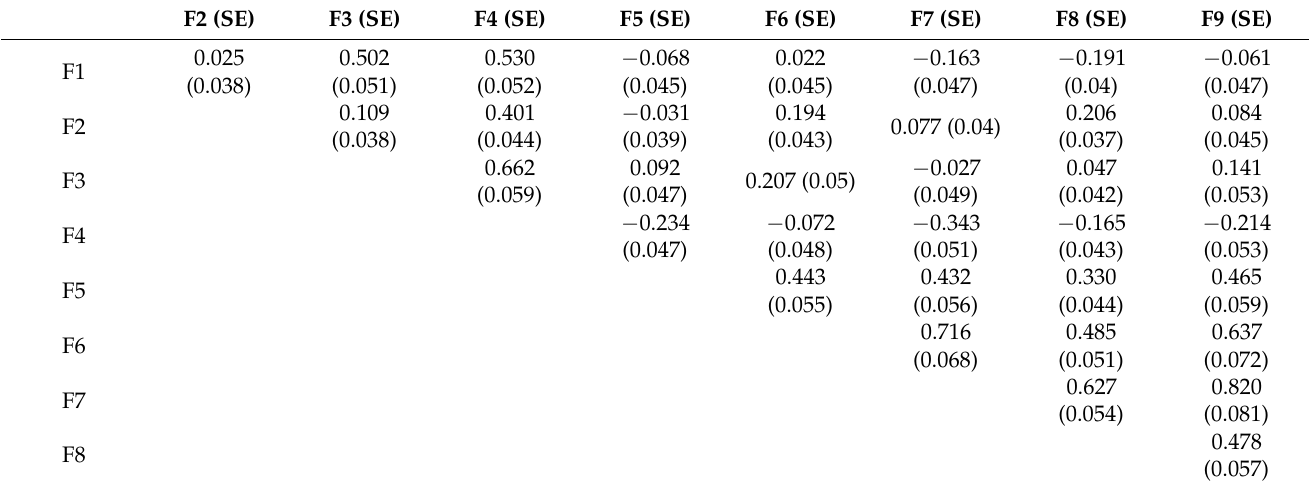
Table 4. Correlations between factors (solution of nine correlated factors and 27 items).